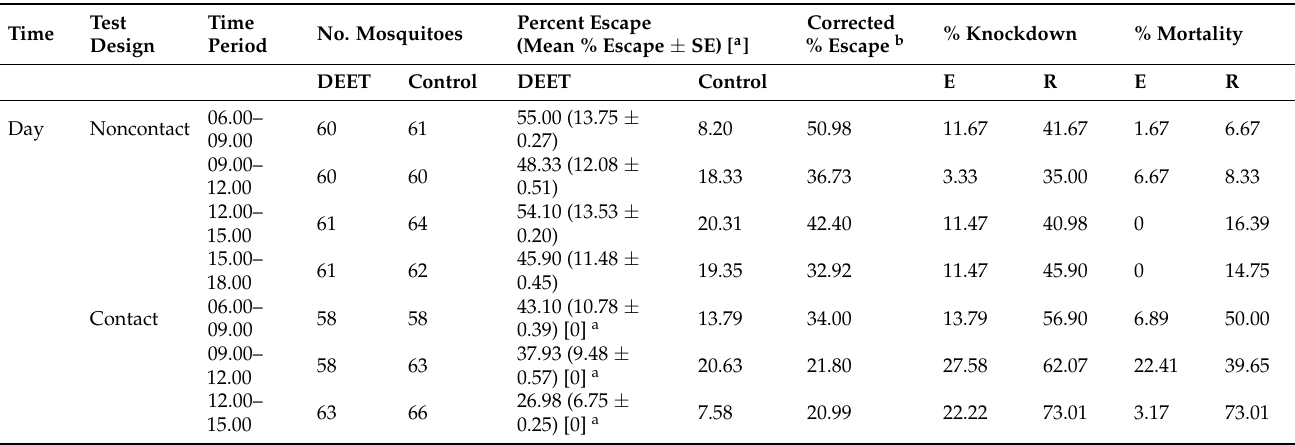
Table 2. The average percent escape, percent knockdown, and 24-h mortality of Anopheles minimus exposed to 5% DEET at different time periods of day and night using the excito-repellency assay system. Test Time